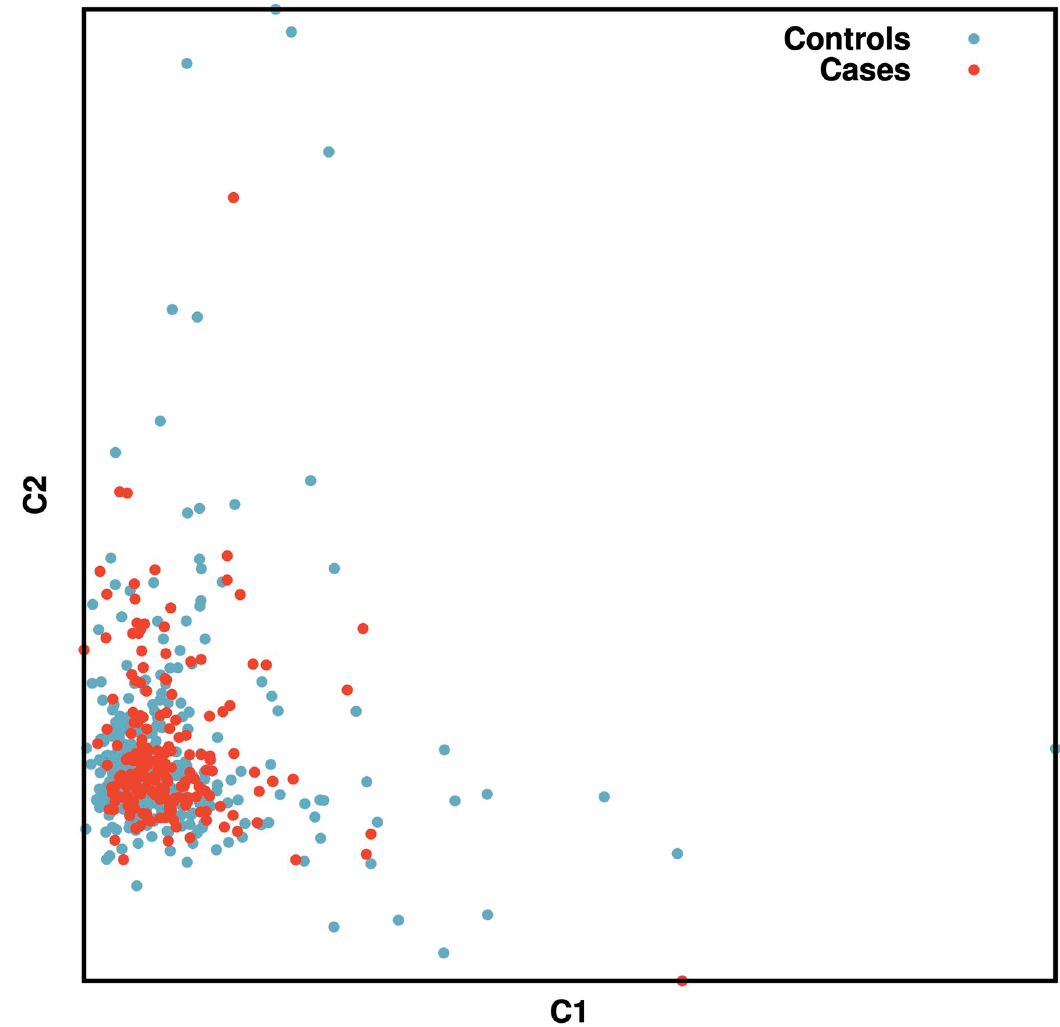
Fig 1. MDS plot of all cats included in the GWAS. On the X axis is the first dimension of the IBS calculation, the Y axis contains the second dimension. The blue dots represent the control cats, while the red dots represent the DM